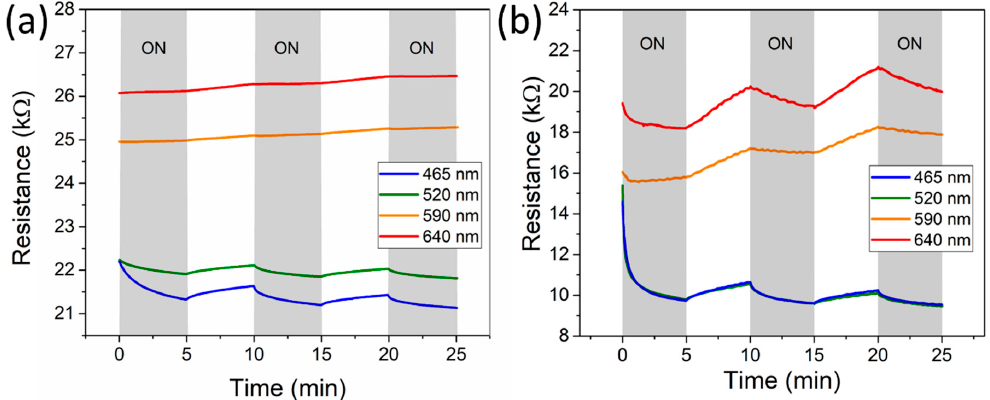
Figure 6. Visible-light-activated on ZnO NRs (ON/OFF mode) for ( a ) the bare ZnO NRs and ( b ) decorated Au NPs.